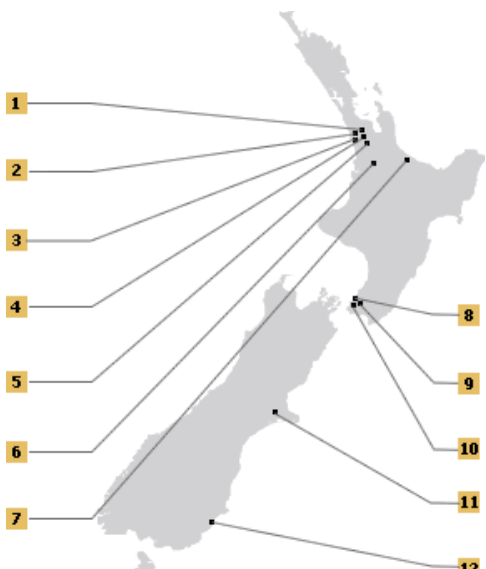
Figure 1: The location of the twelve cities included in the Quality of Life project. New Zealand,